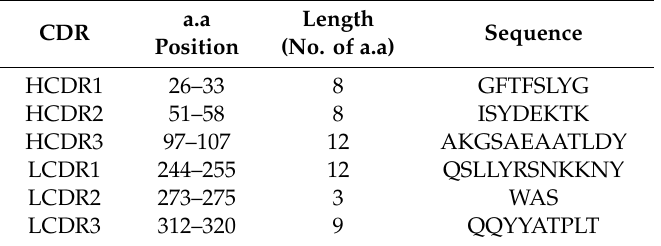
Table 2. Complementarity-determining region (CDR) of